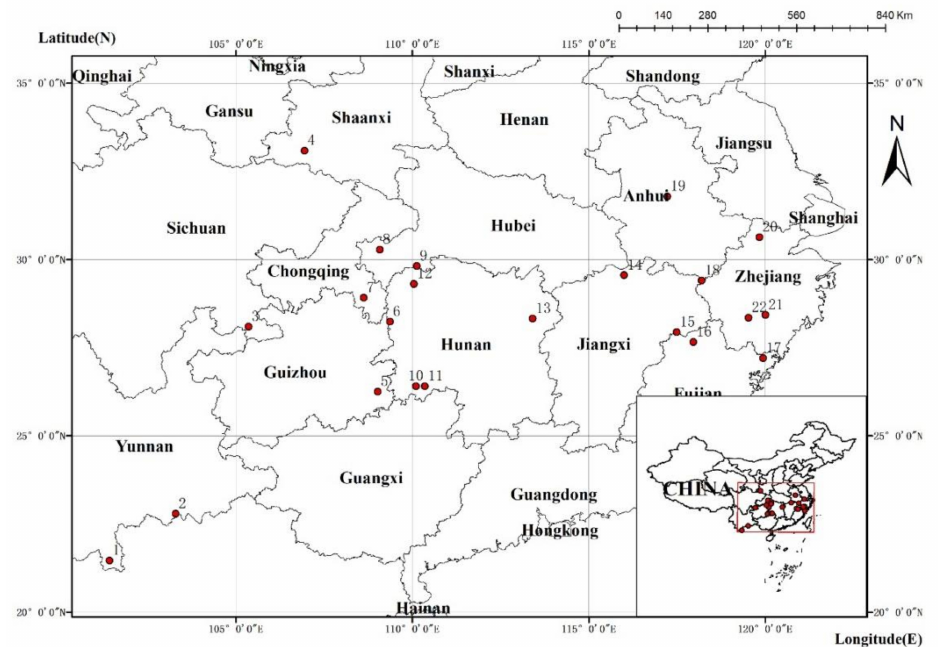
Figure 1. Locations of the 22 geographic populations of L. Chinense . Numbers correspond to the population numbers in Table